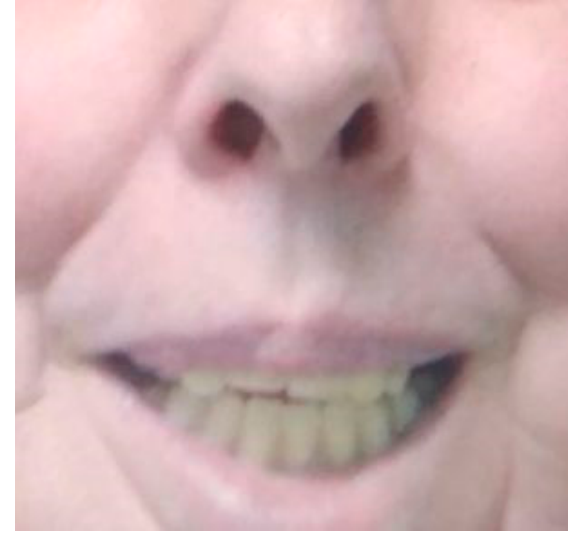
Figure 14. Intraoral view of rehabilitation.